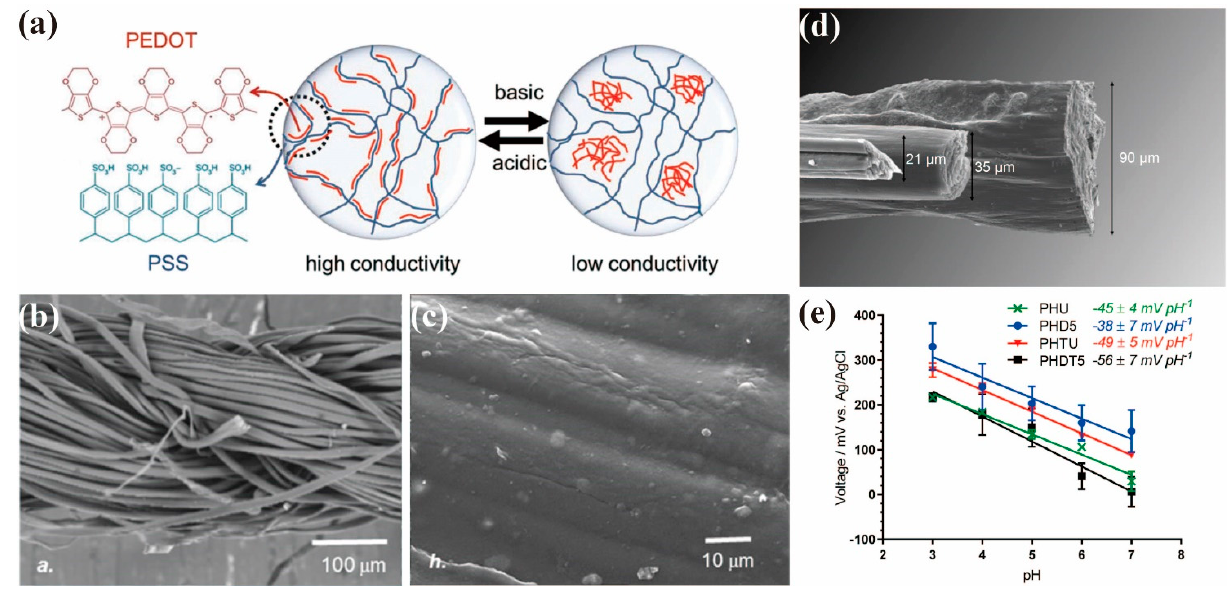
Figure 3. ( a ) Schematic illustration of the impact of pH on molecular structure of PEDOT:PSS [41]; SEM images of ( b ) uncoated cotton and ( c ) PEDOT:PSS-MWCNTs-cotton [40]; ( d ) SEM image comparing three fiber type; ( e ) Potentiometric (open circuit) response of PEDOT:PSS wet-spun fibers coated with PANI. (PHU: 90 μ m PEDOT:PSS fibers without DMSO treatment; PHD5: 90 μ m PEDOT:PSS fibers with 5 min DMSO treatment; PHTU: 20 μ m PEDOT:PSS fibers without DMSO treatment; PHDT5: 20 μ m PEDOT:PSS fibers with 5 min DMSO treatment) [43].